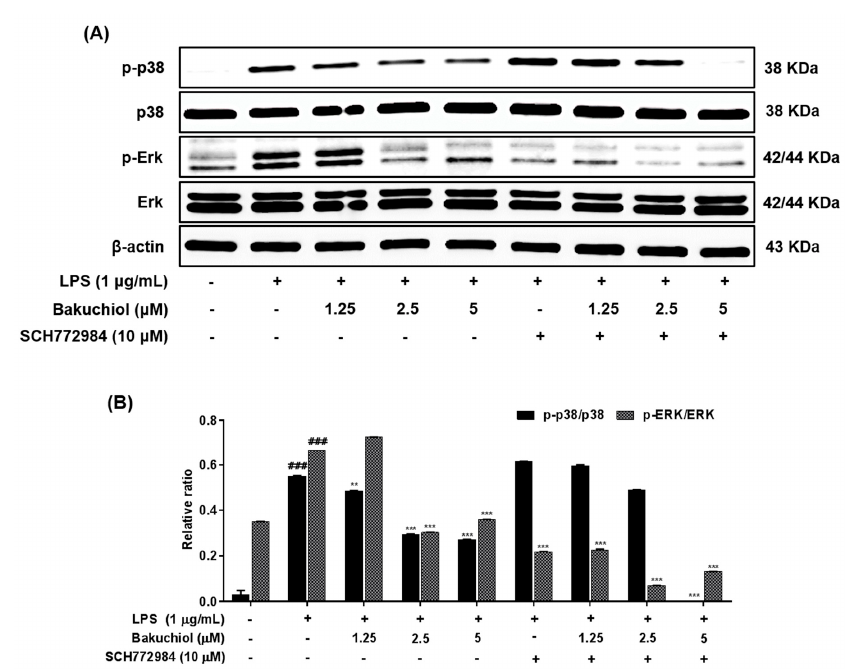
Figure 3. Effects of bakuchiol on mitogen-activated protein kinase (MAPK) phosphorylation in LPS-stimulated BV-2 microglia. The cellular proteins were used for the detection of phosphorylated or total forms of p38 MAPK, extracellular signal-regulated kinase (ERK), and c-Jun N-terminal kinase (JNK) by western blotting ( A ). Bar graphs represent the relative phosphorylation of the p38 MAPK ( B ), ERK ( C ), and JNK ( D ) proteins adjusted to the β -actin protein level. The results are expressed as the mean ± SEM of three independent experiments. ### P < 0.001 vs untreated control cells and *** P < 0.001 vs LPS-treated cells.